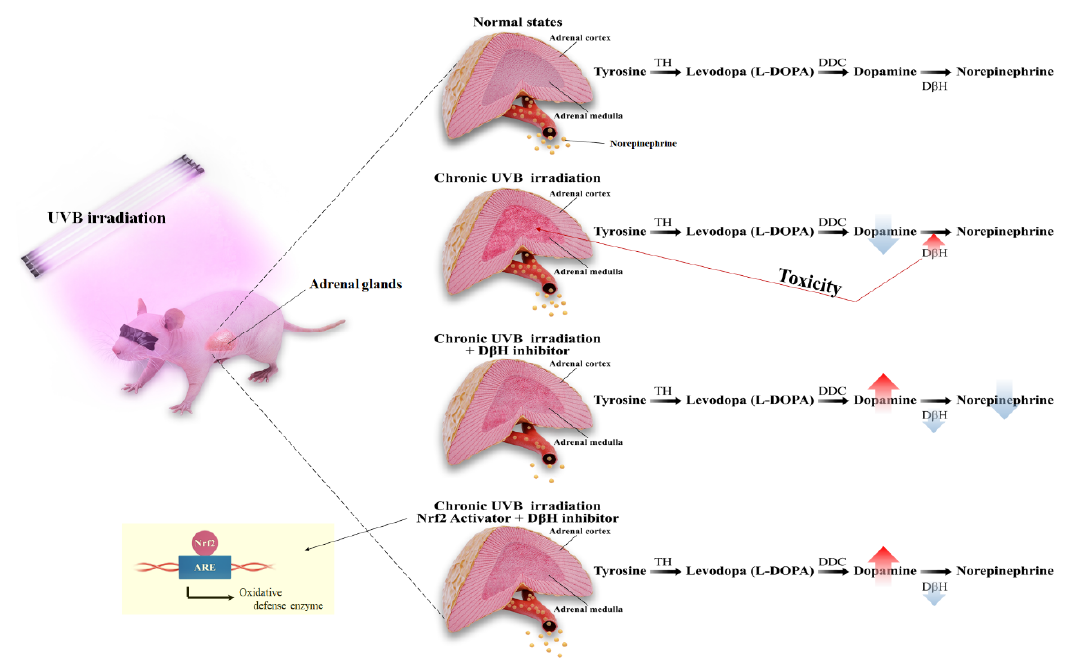
Figure 7. Schematic of the mechanism proposed for chronic ultraviolet irradiation to the skin dysregulating adrenal medulla and dopamine metabolism.